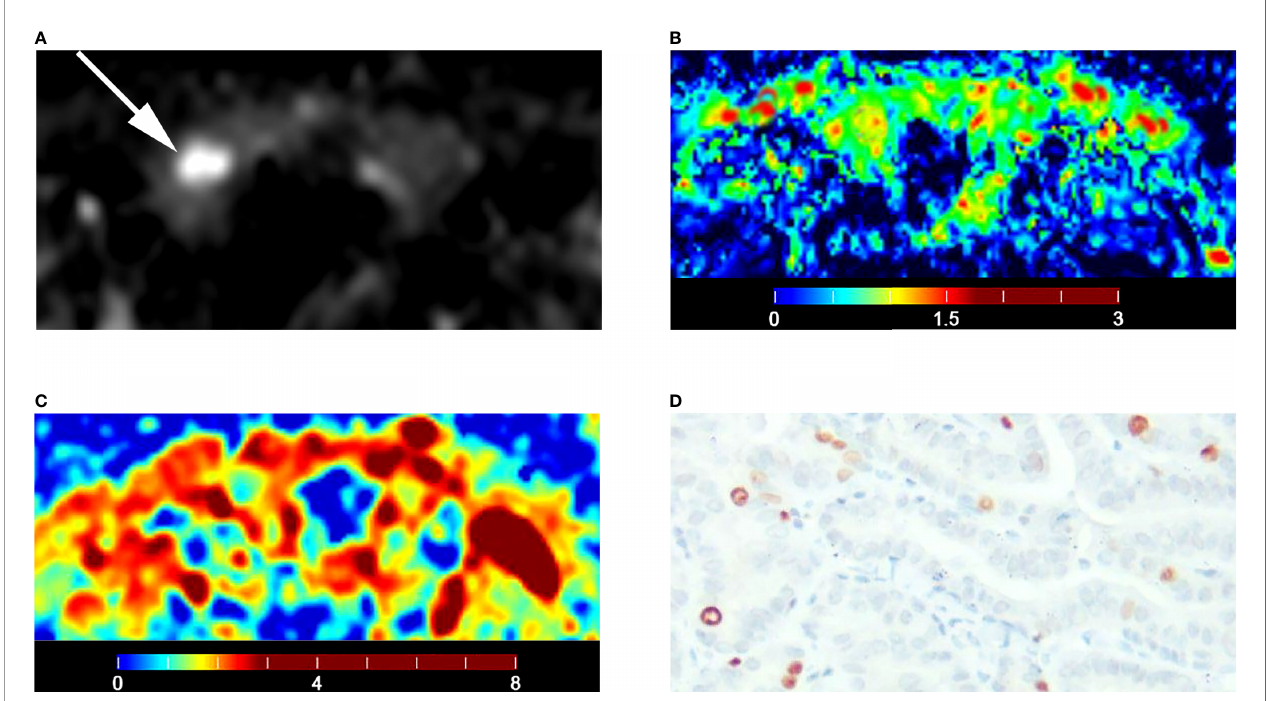
FIGURE 7 | Images of a 51-year-old female with right lobe papillary carcinoma (A-D): (A) axial diffusion image with b = 0; (B) color map of D, D value of lesion is 0.70 × 10 -3 mm 2 /s; (C) color map of D app , D app value of lesion is 1.26 × 10 -3 mm 2 /s; (D) Ki-67 expression is 5% in tumor